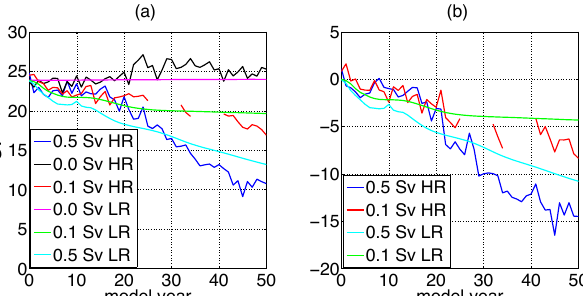
Figure 1. (a) Strength of the Atlantic meridional overturning circu- lation (AMOC) at 35 ◦ N for the HR control simulation (black), the LR control simulation (magenta), the 0.1Sv HR simulation (red, the gaps are due to missing data), the 0.5Sv HR simulation (blue) and the LR 0.5Sv simulation (light blue). (b) AMOC anomalies (with respect to the control simulation) of the different perturbed simula- tions with the same colour coding as in (a) .